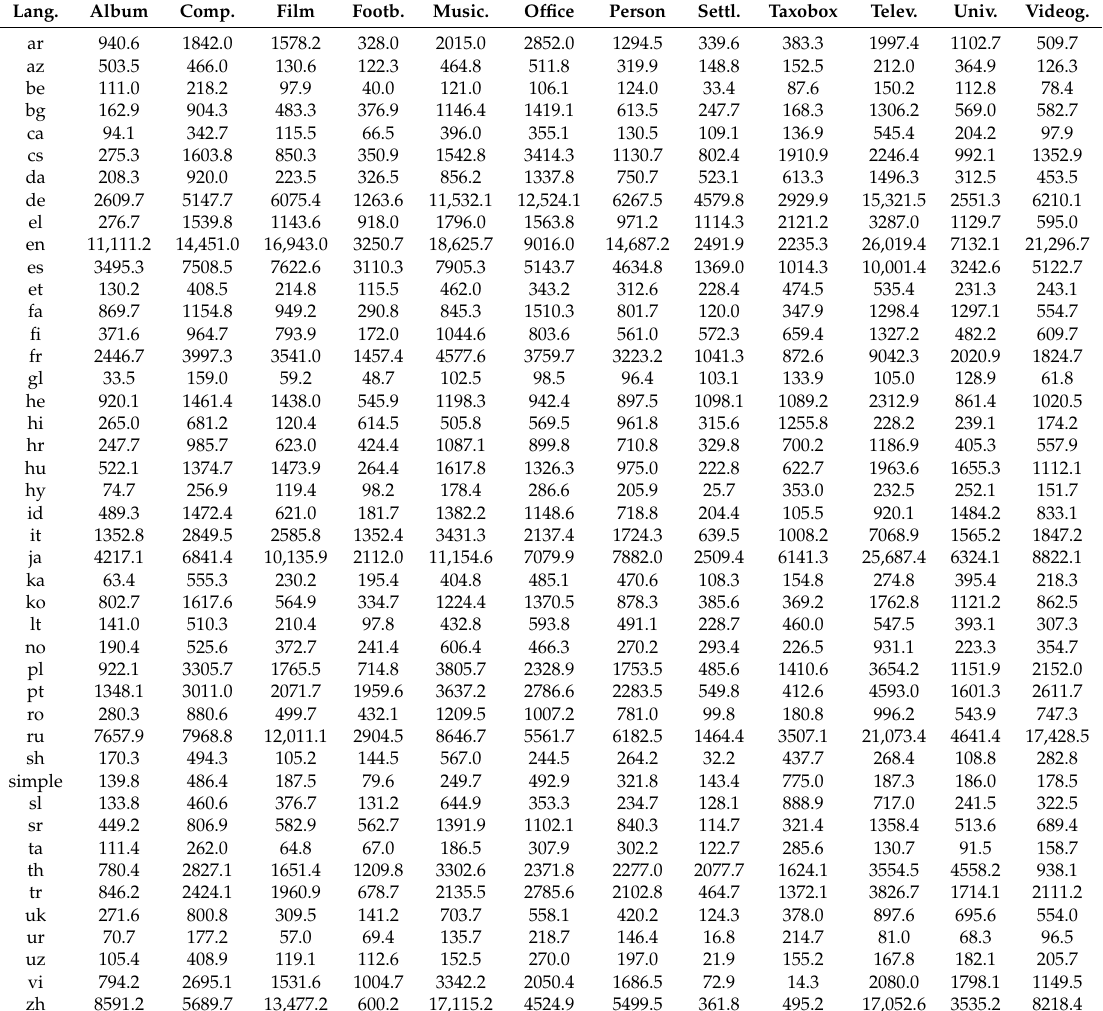
Table 8. Average popularity metric tp in articles for each topic in 44 Wikipedia language editions. Source: own